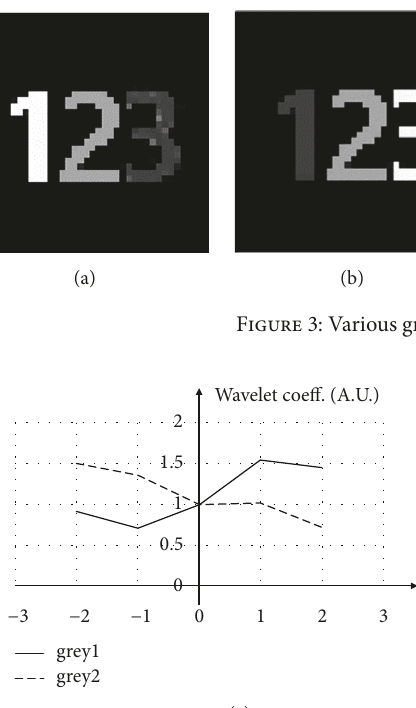
Figure 4: Wavelet coefficients of images from Figure 2: (a) grey-scale, (b) colour.